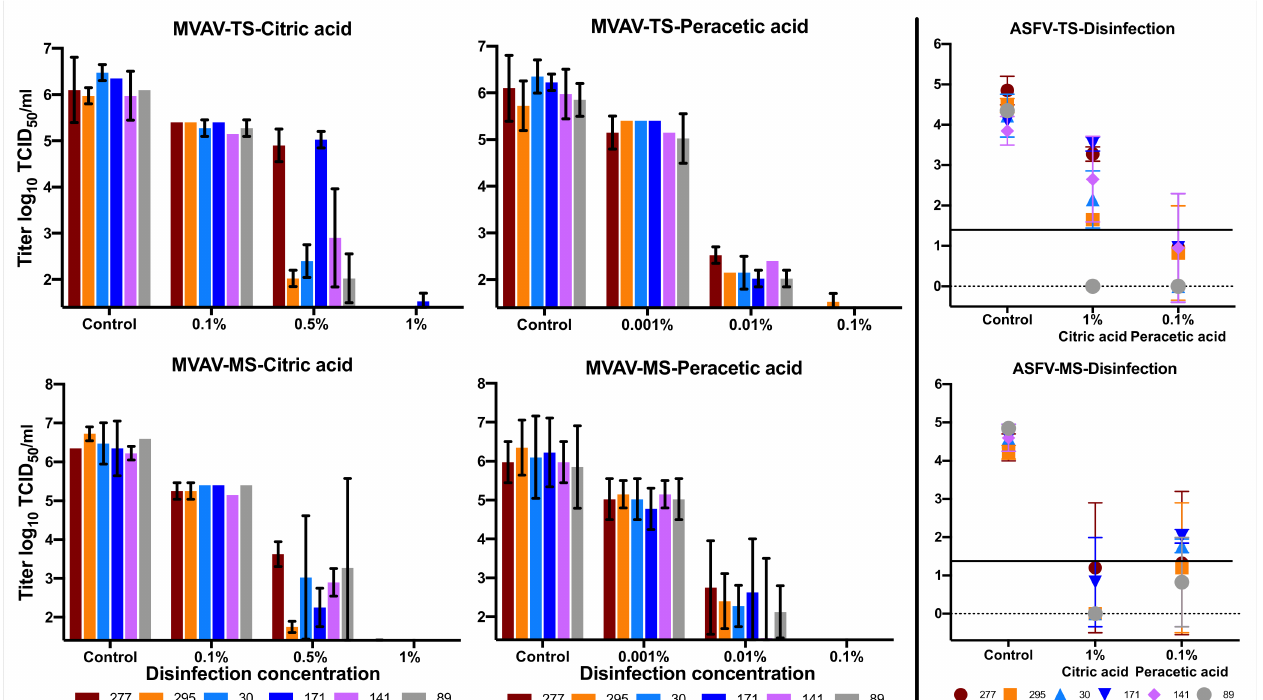
Figure 2. Comparison of the disinfection of MVAV and ASFV (limit of detection 10 1.4 log 10 TCID 50 /mL). Top 3 panels are topsoil (TS) and lower 3 panels are mineral soil (MS). The mean value and standard deviation of at least double measurements are shown for each test point. The virus titers were calculated in the case of the MVAV by CPE and in the case of the ASFV by immunofluorescence. Therefore, different evaluation schemes were used.